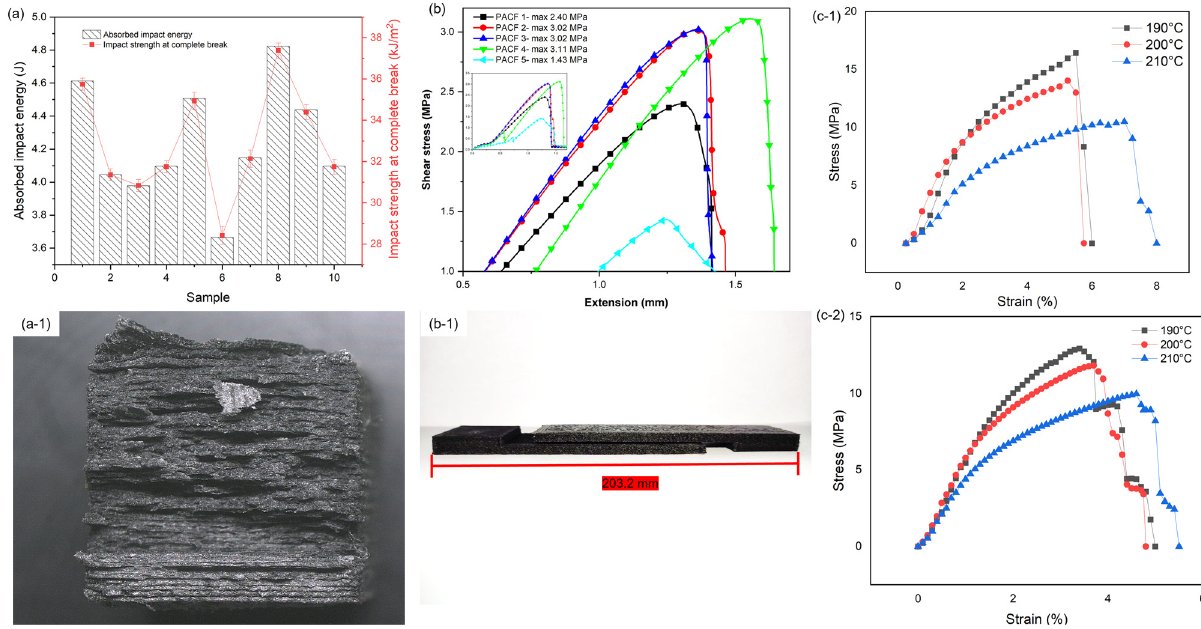
Figure 5: Mechanical strength of printed PACF: ( a ) impact strength with ( a - 1 ) micrograph image of fracture sample view, ( b ) shear strength, ( b - 1 ) shear test sample dimension, and tensile test between 190 and 210°C for ( c - 1 ) 5 h and ( c - 2 ) 20